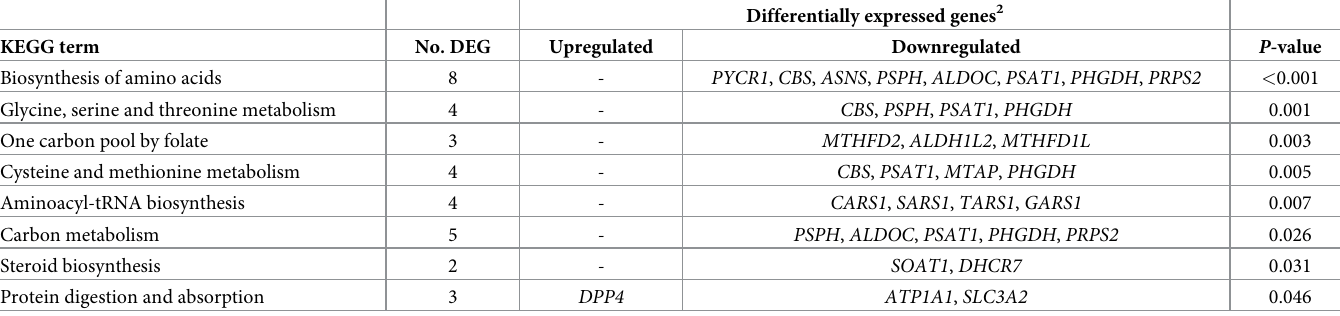
Table 2. Significantly enriched Kyoto Encyclopedia of Genes and Genomes (KEGG) pathways in the Longissimus dorsi muscle of early-weaned Bos indicus -influ- enced calves for the effect of maternal supplementation with methionine hydroxy analog 1 . Differentially expressed genes